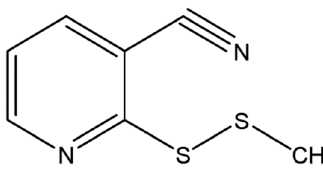
Figure 1. Two-dimensional (2D) structure of 2-(methyldithio)pyridine-3-carbonitrile (2-Medpy-3- CN).